Question: Generate an informative caption for the figure above.
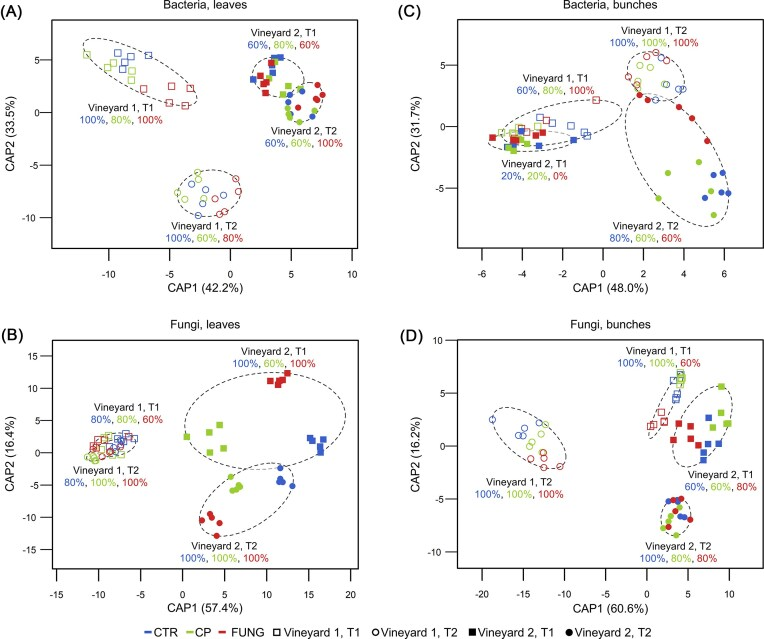
Answer: Constrained analysis of principal coordinates (CAP) of grapevine phyllosphere micro-organisms. CAP was obtained for bacterial and fungal communities of leaves (A, B) and bunches (C, D) collected from control plants (CTR; blue) and plants treated with 16 mM choline pelargonate (CP; green) or with a combination of copper and sulfur as reference fungicides (FUNG; red), at blooming (T1; square symbols) and bunch closure (T2; circle symbols) in vineyard 1 (empty symbols) and vineyard 2 (solid symbols) based on Bray–Curtis dissimilarity matrices. The effects of vineyard, time point, and treatment were evaluated using multivariate permutational analysis of variance (PERMANOVA with 999 permutations; Supplementary Table S10 ). Dashed ellipses enclose samples from the same vineyard and time point, and percentages indicate the reclassification success of samples (percentage of correctly assigned samples).